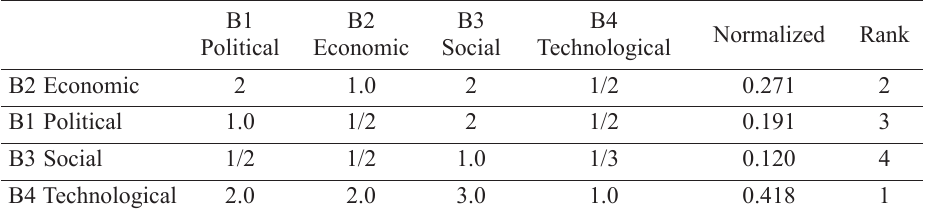
Table 3. Pair-wise comparison and determination of priorities in the line with the benefit merit B1